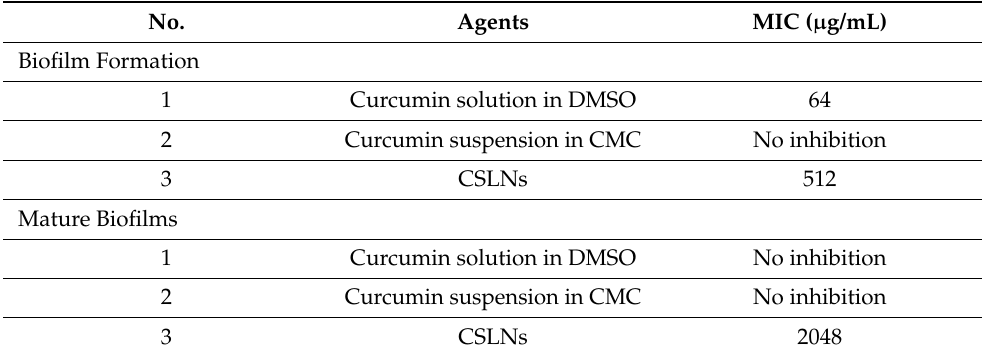
Table 11. Antimicrobial effect of CSLNs against Staphylococcus aureus ATCC 9144 biofilms. No. Agents MIC ( µ g/mL) Biofilm